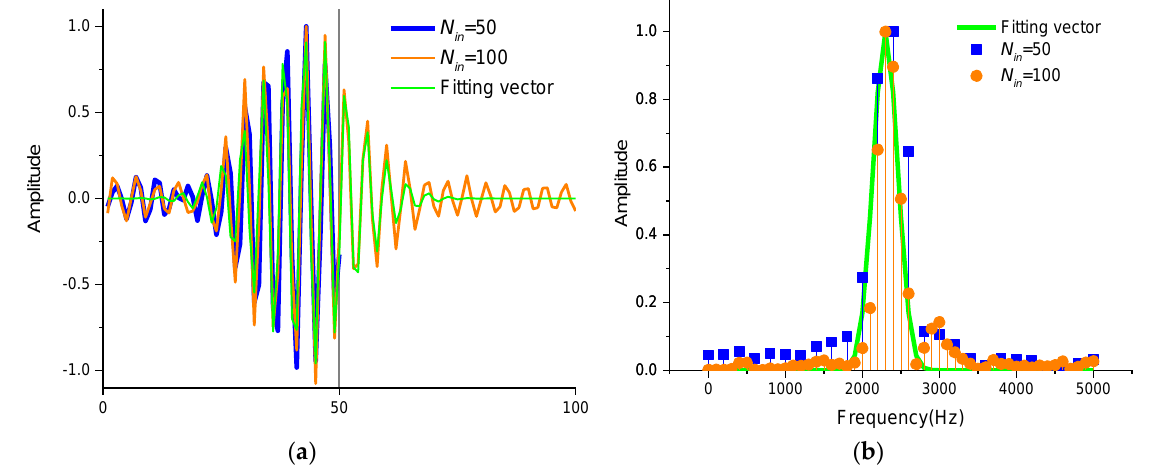
Figure 7. Selected weight vectors for the motor bearing dataset and the fitting vector by Gabor function: ( a ) Vectors in the time domain; ( b ) Fourier transforms.